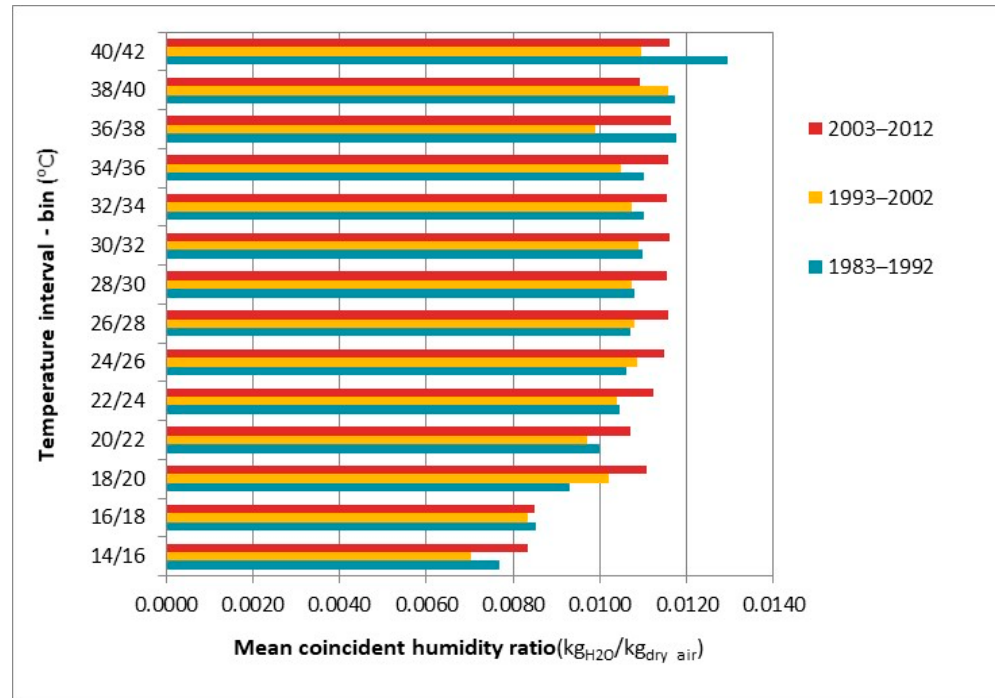
Figure 5. Mean coincident humidity ratio, in 2 °C temperature intervals, Athens (NOA) (cooling season—June to September).